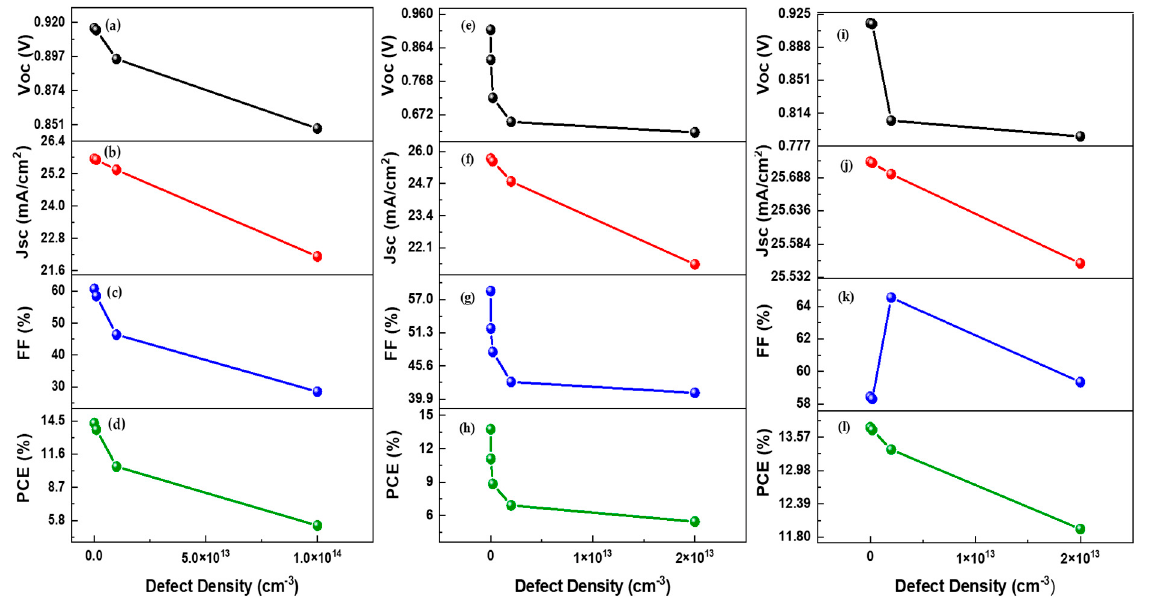
Figure 6. ( a , e , i ) Voc as a function of active layer, IL1, and IL2 defect density; ( b , f , j ) Jsc as a function of active layer, IL1, and IL2 defect density; ( c , g , k ) FF as a function of active layer, IL1, and IL2 defect density; and ( d , h , l ) PCE versus active layer, IL1, and IL2 defect density.